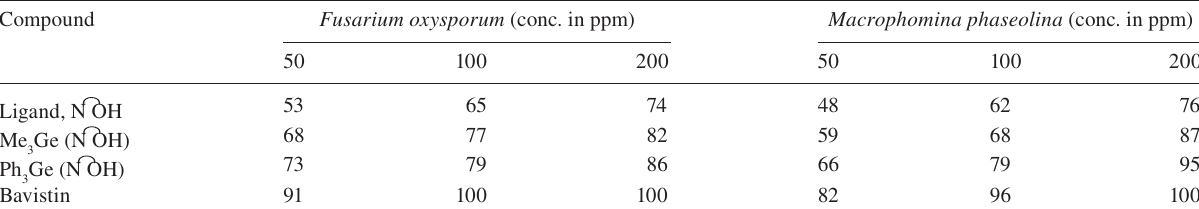
Table 2 Antifungal screening data of the ligand and its organogermanium complexes.